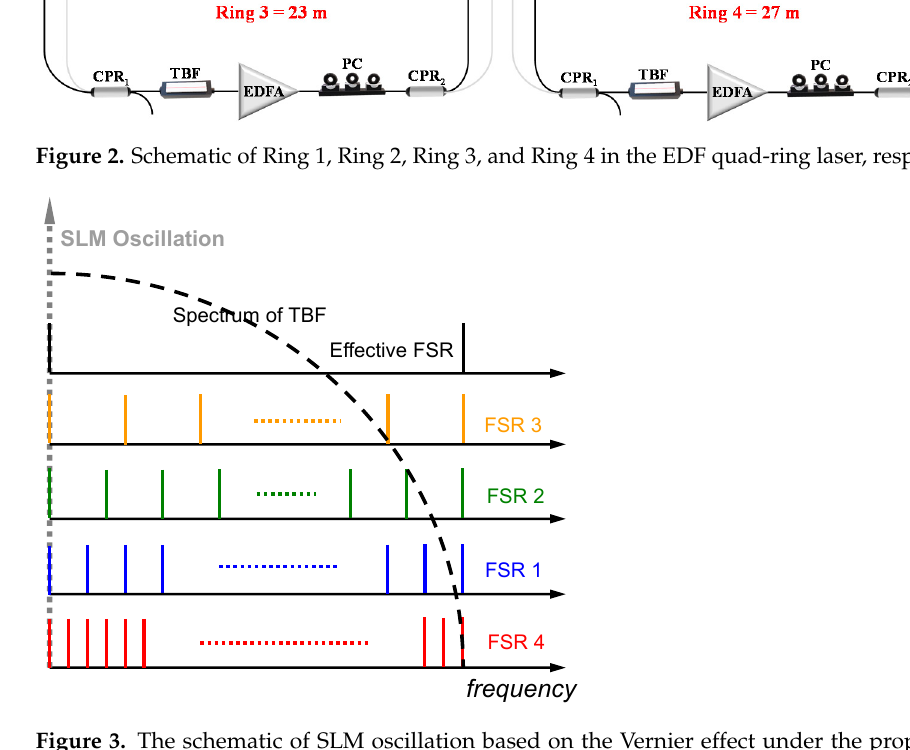
Figure 3. The schematic of SLM oscillation based on the Vernier effect under the proposed fiber structure of Ring 1 to Ring 4.